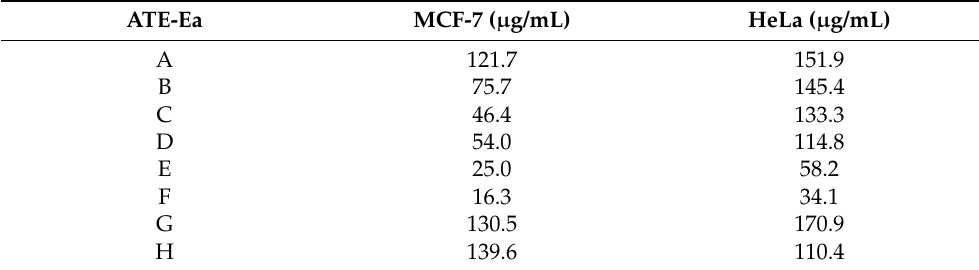
Table 2. The IC50 of the ATE-Ea subfractions in MCF-7 and HeLa